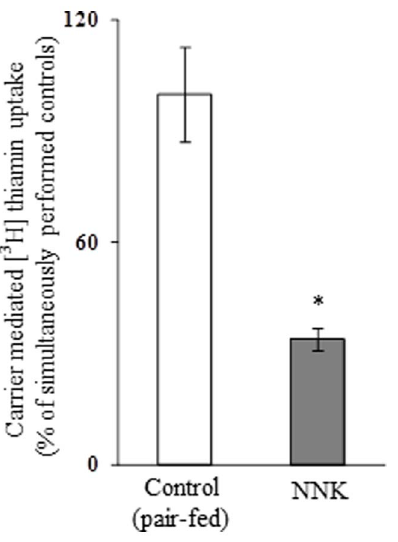
Figure 5. Effect of chronic exposure of mice to NNK on carrier- mediated [ 3 H]-thiamin uptake by primary pancreatic acinar cells. Primary pancreatic acinar cells were isolated from mice exposed to NNK (10 mg/100 g body weight, 26) and from their pair-fed controls. Carrier-mediated thiamin uptake was determined as described in Methods. Data are mean 6 SE of at least 3 separate uptake determinations from multiple sets of mice. * P , 0.01. doi:10.1371/journal.pone.0078853.g005 536 bp for SLC19A2 and three CpG island of 112, 108 and 114 bp for SLC19A3 . We then used the results of the Methprimer analysis to design primers that did not contain CpG dinucleotide sequences (Table 1) and amplified the CpG regions of the respective promoters after bisulfite conversion of DNA isolated from control and NNK exposed 266-6 cells followed by sequencing for the identified regions as described previously [41]. The results,